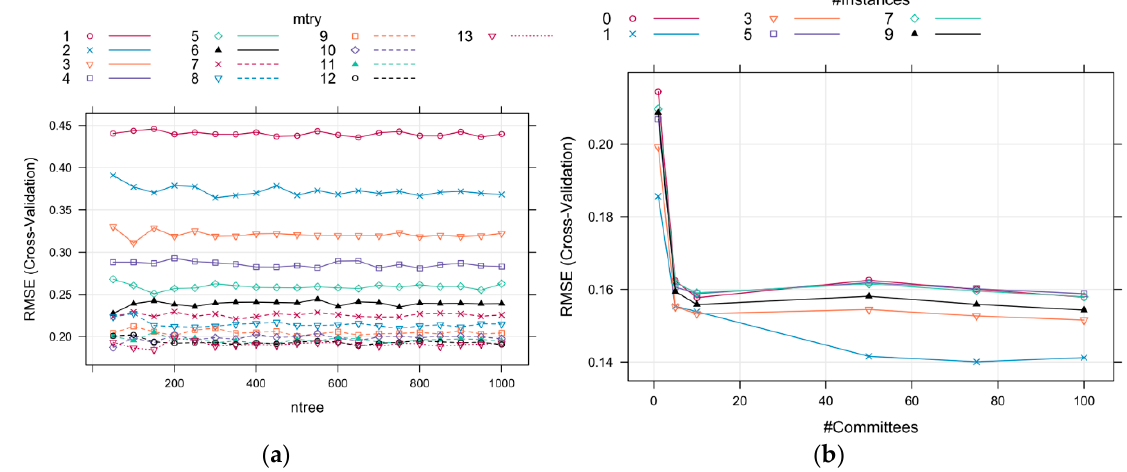
Figure 4. Fivefold cross-validated RMSE profiles for determining the optimal tuning parameters: ( a ) Random forests model, and ( b ) Cubist model.